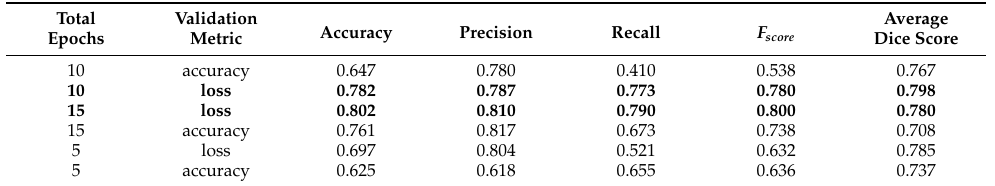
Table 2. Results of server-centric initial model training for transfer learning experiments. The best performance is highlighted in bold.